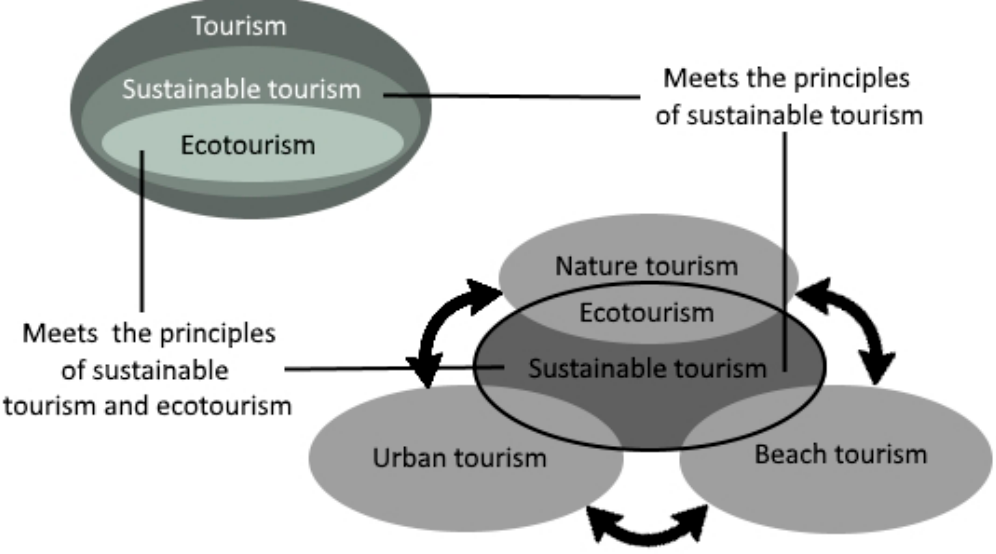
Figure 2. Relationship between ecotourism and sustainable tourism.